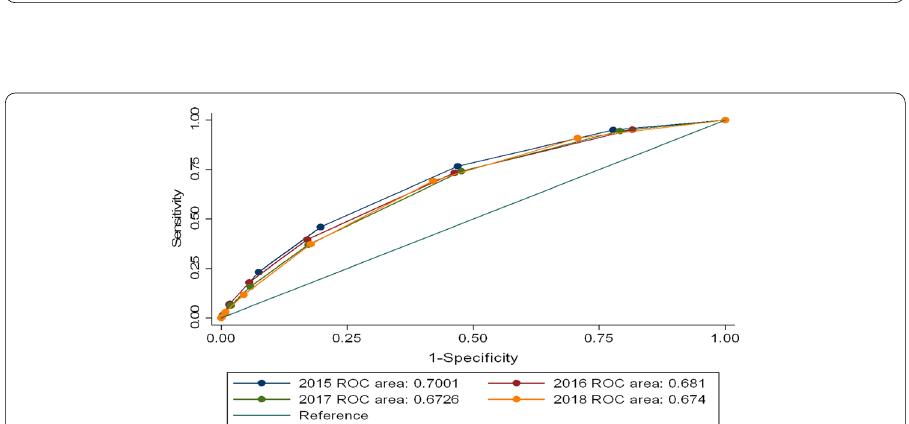
Fig. 5 ROC curve of Lending Club grades. Notes. This Figure plots the ROC curve, which plots the positive true rate, also called Sensitivity versus true false rate (1-Specificity), obtained by using the LC rating grade as a predictor of defaulted loans. The analysis is performed each year separately on loans issued between 2016 and 2018. The larger the AUC, the better the model